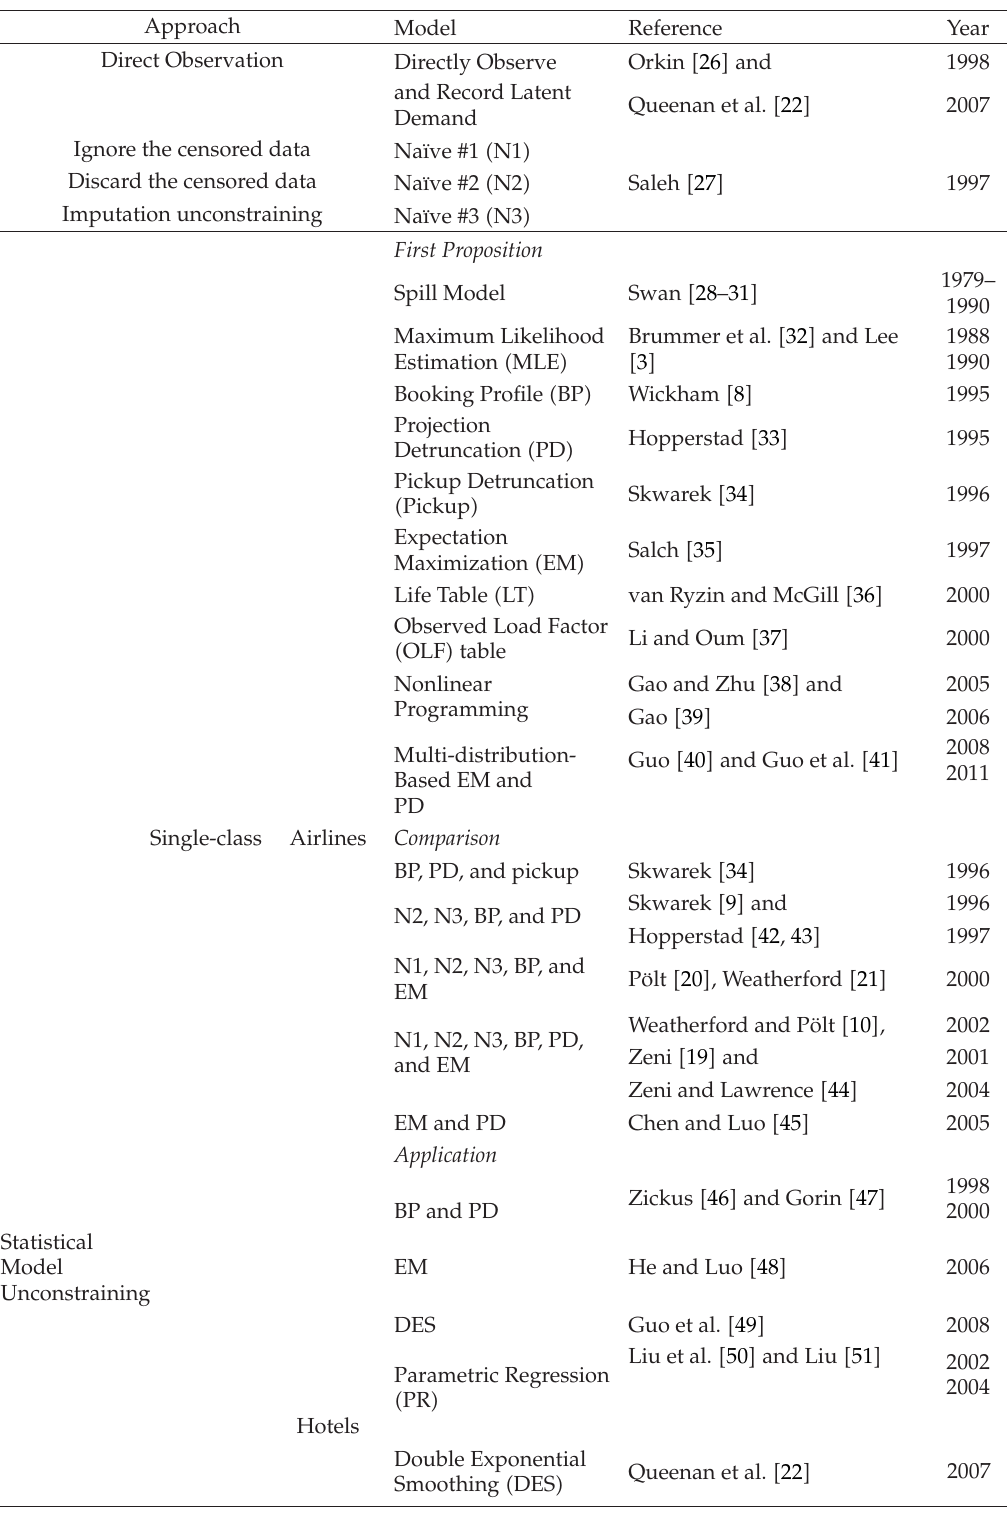
Table 5: Research on unconstraining methods used in